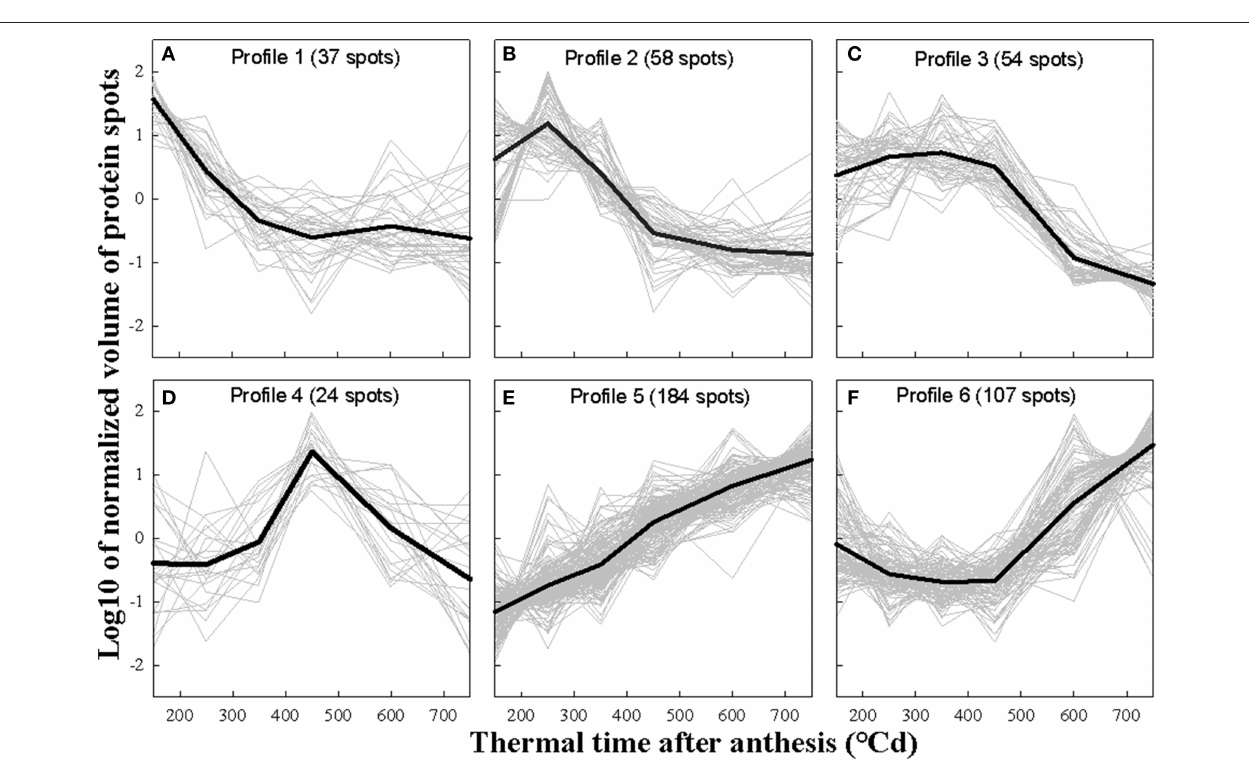
FIGURE 5 | Abundance profiles of variant protein spots. Six profiles (A–F) were established from the normalized volumes of the 464 variant spots using hierarchical clustering on principal components. Data are means of n = 4 replicates. In each profile, the black line represents the mean. The number of protein spots in each profile is given in parenthesis after the profile